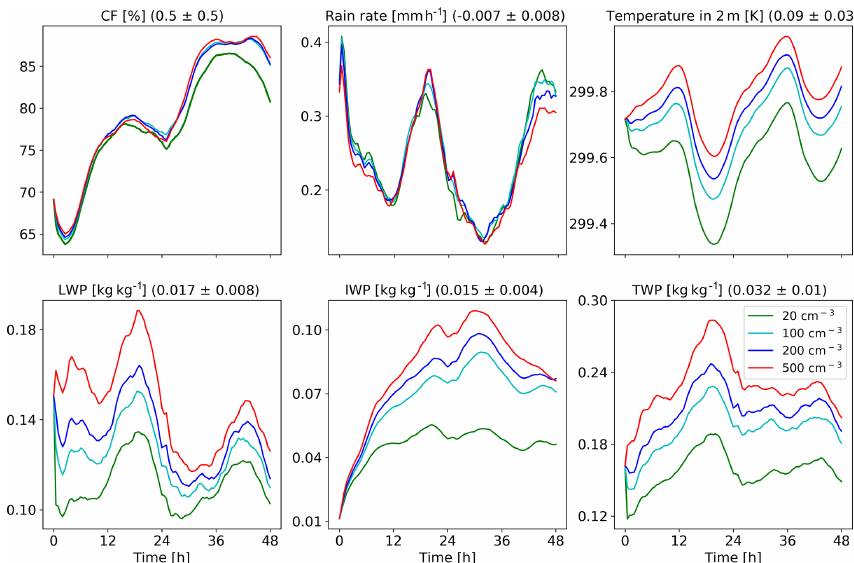
Figure 16. Domain-average properties as a function of time for the different CDNC simulations for the deep-cloud-dominated case. The properties that are presented here are as follows: cloud fraction (CF), rain rate, temperature in 2m, liquid water path (LWP – based on the cloud water mass, excluding the rain mass for consistency with satellite observations), ice water path (IWP) and total water path (TPW = LWP + IWP). For each property, the mean difference between all combinations of simulations, normalized to an increase in CDNC by a factor of 5, and its standard deviation appear in brackets.